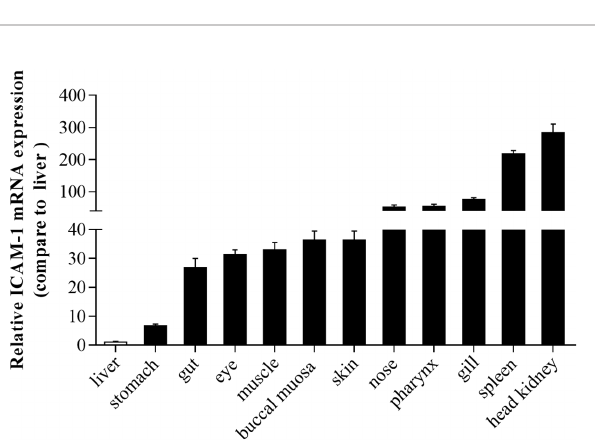
FIGURE 3 | The expression pattern of ICAM-1 mRNA in different tissues of Oncorhynchus mykiss. Relative expression of ICAM-1 was detected in different tissues compared to the liver